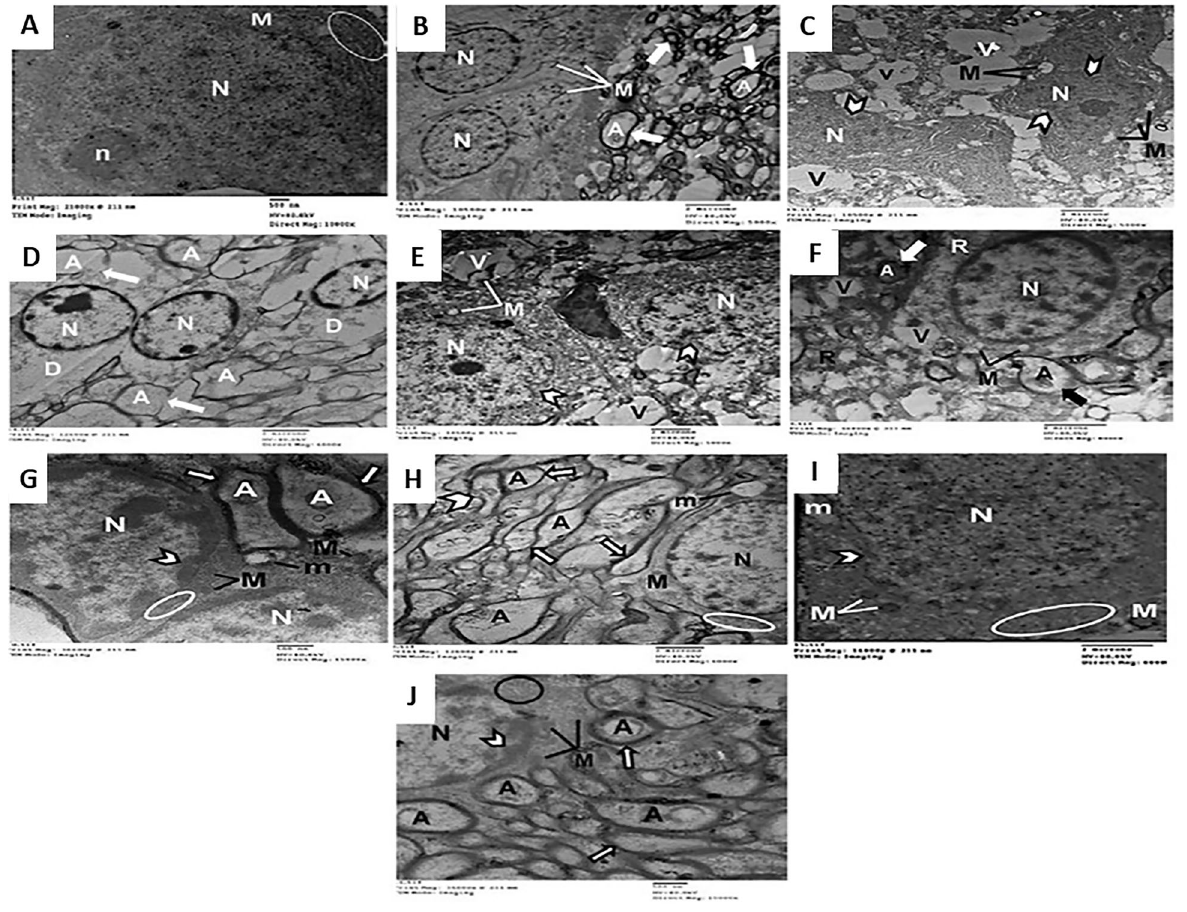
Figure 8. Electron micrographs of ultrathin sections of rat hippocampus (7 – 8 months age). Control and ouabain-treated groups revealing ( A ) pyramidal cell from CA3 zone revealing normal structure, intact organelles within scanty cytoplasm, mitochondria (M), and rough endoplasmic reticulum (circle). Large triangular nucleus (N) with dispersed distribution of chromatin and prominent nucleolus (n) are also seen ( (cid:1) 10,000; scale bar: 500 nm), ( B ) granular cells displaying well circumscribed mitochondria (M) and prominent nuclei (N) with well-de fi ned nuclear envelope. The surrounding neuropil showing myelinated axons (A) with regular compact myelin sheath (arrows) ( (cid:1) 5000; scale bar: 2 m m). Immobilization-stress group ( C ) with pyramidal cells demonstrating wide areas of cytoplasmic vacuolation (V) and swollen mitochondria (M) with disturbed cristae. The nucleus (N) exhibited highly condensed chromatin as well as indentation of nuclear envelope (arrowheads) ( (cid:1) 5000; scale bar: 2 m m), ( D ) granular cells revealing large areas of degenerated cytoplasm (D), margination of the nuclear chromatin (N), as well as destruction (arrows) of myelin sheath of the axons (A) ( (cid:1) 6000; scale bar: 2 m m). Disturbed dark/light cycle group ( E ) vacuolated cytoplasm (V), mitochondria with disturbed cristae (M), and indented nuclear envelop (arrows) of nucleus (N) displaying scattered areas of condensed chromatin ( (cid:1) 5000; scale bar: 2 m m), ( F ) granular cell revealing either rarefaction (R) or vacuolation (V) of the cytoplasm as well as disturbed cristae within the mitochondria (M). Margination of chromatin within the nucleus (N) and destruction (arrows) of myelin sheath of the axons (A) are also noted ( (cid:1) 8000; scale bar: 2 m m). Immobilization-ouabain group ( G ), pyramidal cells revealing regular nucleus with minimal condensed chromatin (arrowhead), apparently normal mitochondria (M) except for few swollen (m) and intact rough endoplasmic reticulum (circle). The surrounding neuropil showing regular compact myelin sheath (arrows) of the axons (A) ( (cid:1) 15,000; scale bar: 500 nm), ( H ) apparently normal mitochondria (M), and rough endoplasmic reticulum (circle) within the granular cell cytoplasm apart from one dilated mitochondrion with ruptured cristae (m). Large spherical euchromatic nucleus (N) and seemingly normal axons (A) with regular compact myelin sheath (arrows), except for few axons with broken myelin sheath (arrowheads) are also seen ( (cid:1) 6000; scale bar: 2 m m). Prolonged darkness-ouabain group ( I ) with pyramidal cells with apparently normal organelles; rough endoplasmic reticulum (circle) and intact mitochondria (M) except for one dilated (m) as well as slight indentation of nuclear envelope (arrowheads) with few areas of condensed chromatin within the nucleus (N) ( (cid:1) 8000; scale bar: 2 m m), ( J ) seemingly normal granular cell including regular mitochondria (M), intact rough endoplasmic reticulum (circle), and spherical nucleus (N) with well-de fi ned nuclear envelop except for small areas of condensed chromatin (arrowhead). Axons (A) revealing regular compact myelin sheath (arrows) ( (cid:1) 15,000; scale bar: 500